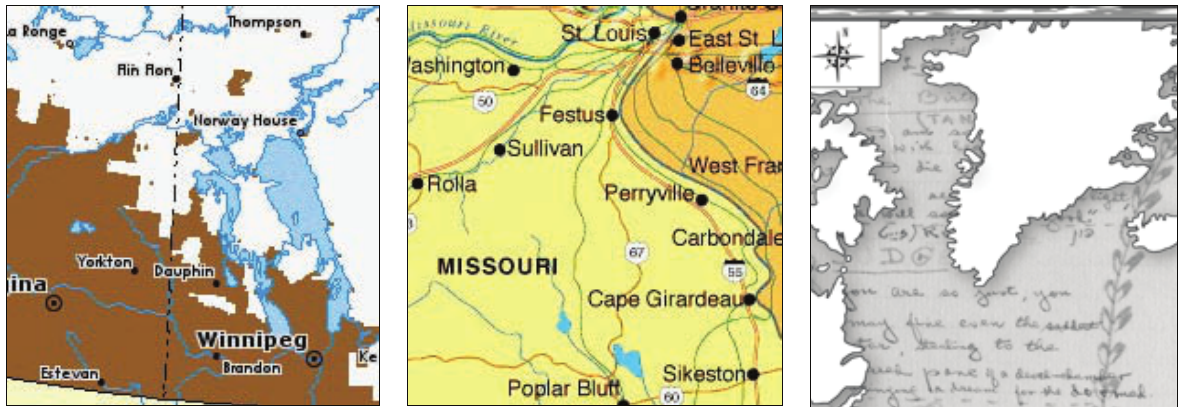
Fig. 3. ‘Minimal’, ‘standard’ and ‘stylish’ (from the left) map samples